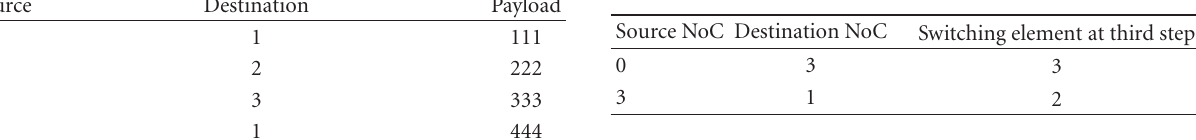
Table 22: Intermediate SE information while data moves from